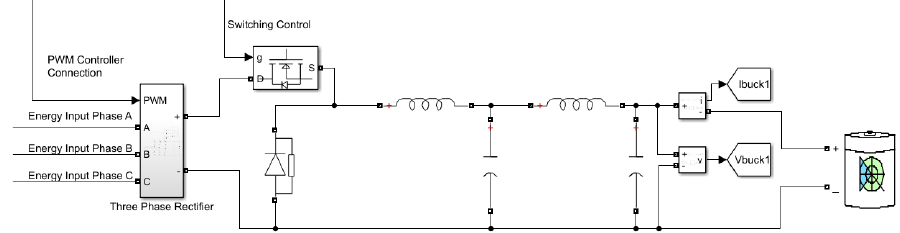
Figure 1. Electric vehicle DC charging